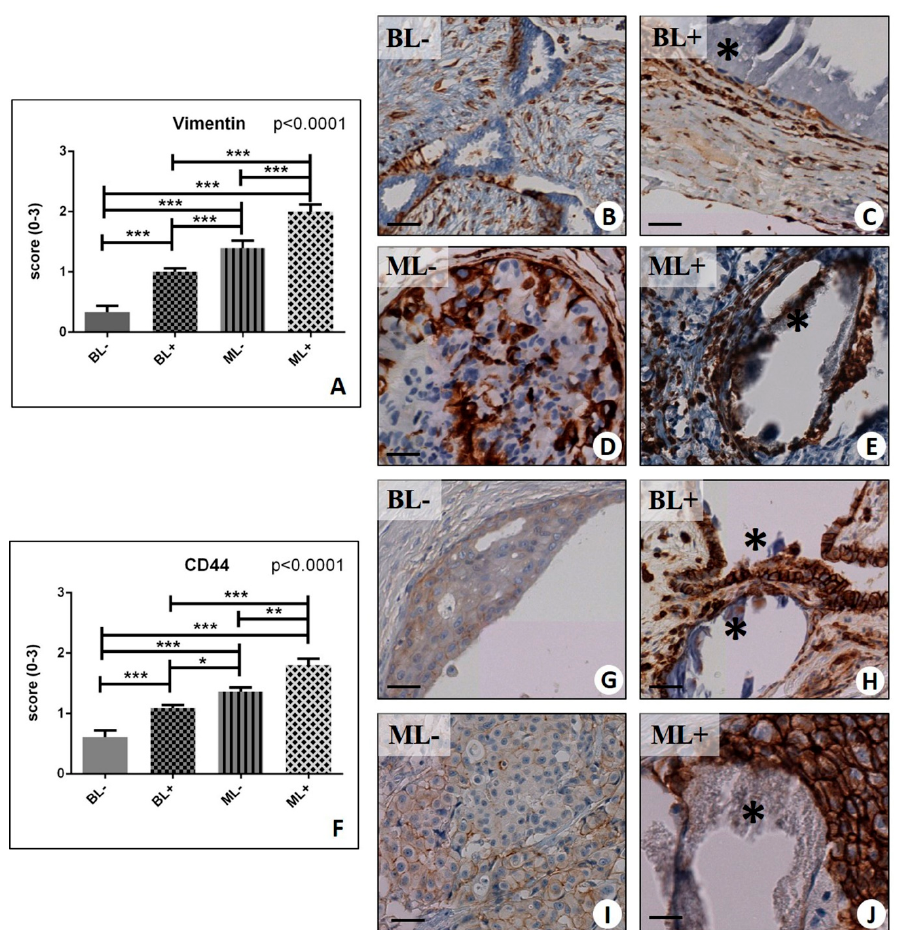
Figure 1. Immunohistochemical evaluation of Vimentin, and Cluster of Differentiation (CD44). ( A ) Graph shows the expression of vimentin in BL − , BL + , ML − , and ML + groups. ( B ) Image displays vimentin expression in a case of fibroadenoma without macrocalcifications. ( C ) Micrograph showed several vimentin-positive breast cells next to microcalcification (asterisk) in a fibroadenoma. ( D ) Numerous vimentin-positive breast cancer cells in a ductal in situ carcinoma. ( E ) Image shows a calcification (asterisk) surrounded by vimentin-positive infiltrating breast cancer cells. ( F ) Graph shows the expression of CD44 in BL − , BL+, ML − , and ML+ groups. ( G ) No/rare CD44 positive cells in breast fibroadenoma. ( H ) Breast microcalcification (asterisks) in a fibroadenoma surrounded by CD44-positive cells. ( I ) Infiltrating breast carcinomas with rare CD44-positive cells. ( J ) Micrograph displays several CD44-positive breast cancer cells close to the microcalcifications (asterisk) in infiltrating breast cancer. (* p < 0.05; ** p < 0.01; *** p < 0.001). Scale bar represents 100 µ m in all